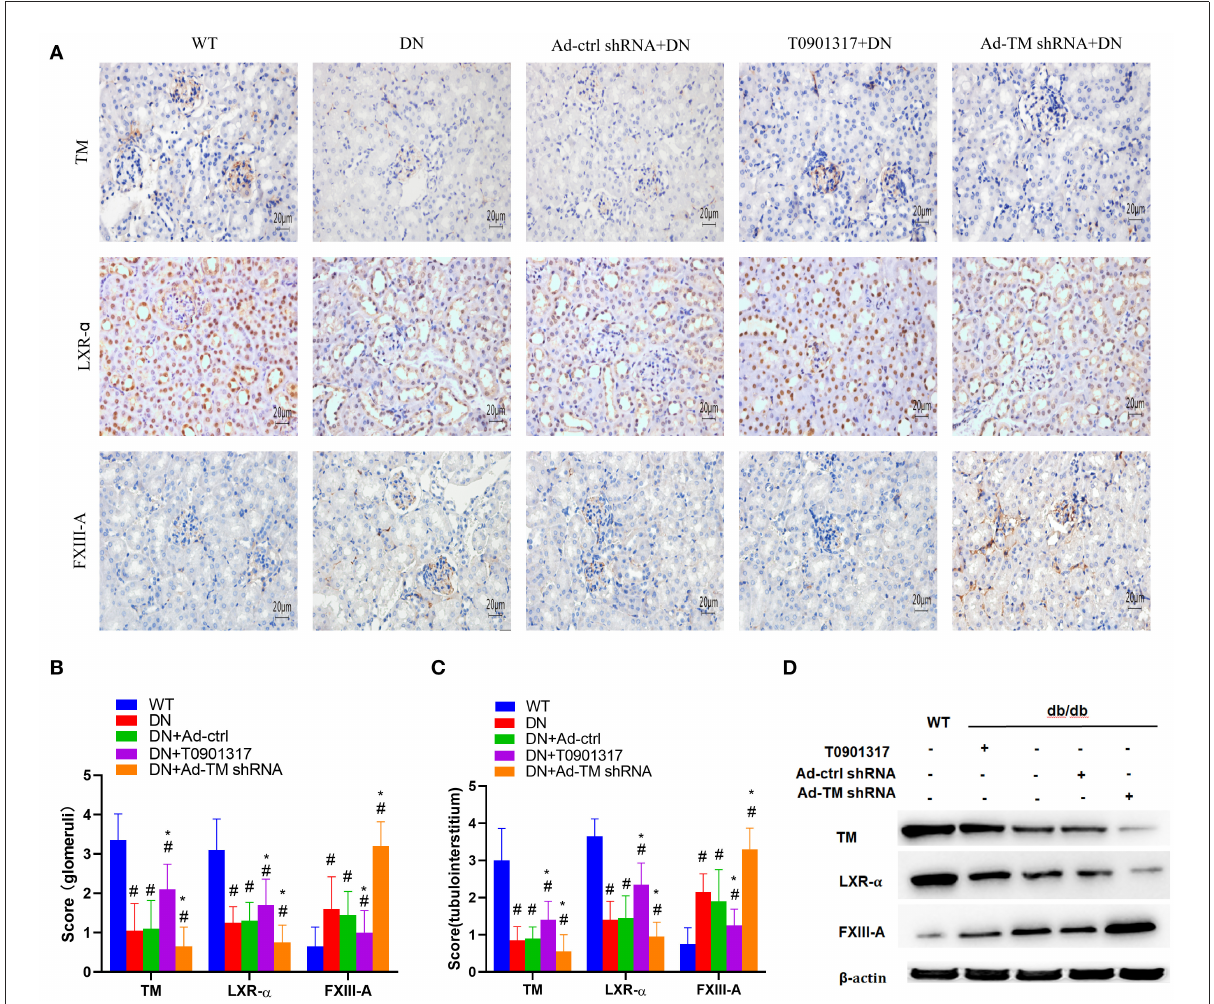
FIGURE3 The expression of TM, LXR- α and FXIII-A detected by immunohistochemical staining and western blot in db/db mice and wild mice. db/db mice were divided into four groups: DN; Ad-ctrl + DN; T0901317 + DN and Ad-TM shRNA + DN. The wild mice were as control. (A) Representative images of immunohistochemical staining of TM, LXR- α and FXIII-A. Scale bar = 20 µ m. (B, C) Score of positive staining for TM, LXR- α and FXIII-A in the kidney tissue ( n = 6, mean ± SEM). * p < 0.05 compared with the WT group. # p < 0.05 compared with the DN group and Ad-ctrl + DN group. (D) The expression of TM, LXR- α and FXIII-A detected by western blot in db/db mice and wild